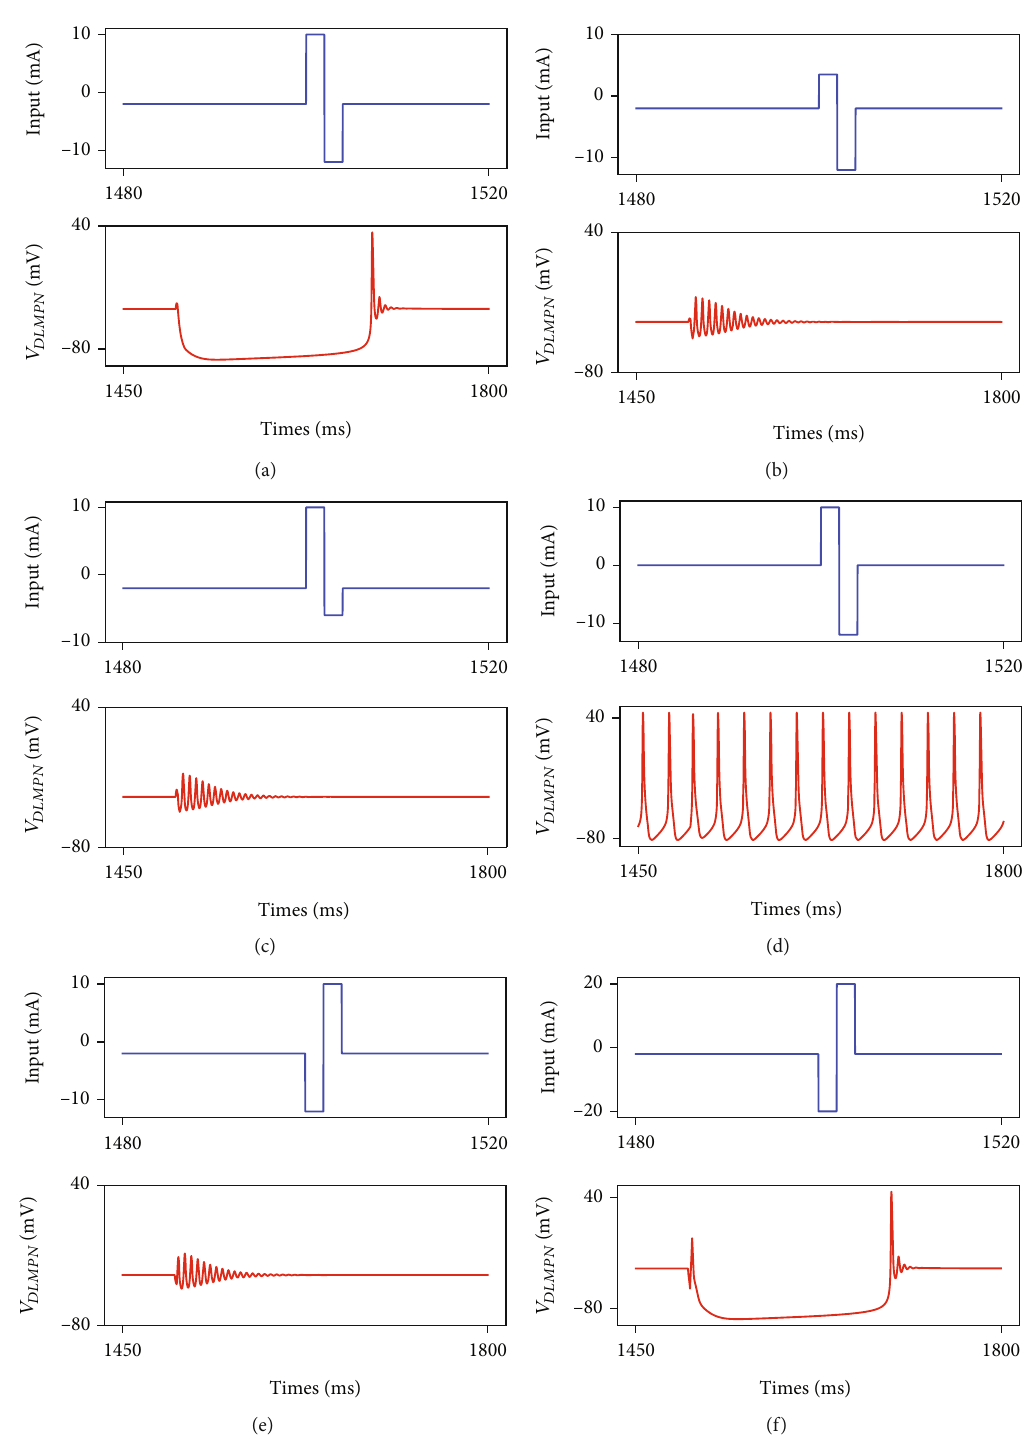
Figure 7: The activities of a single DLM projection neuron under di ff erent currents. (a) I = − 2 mA , I (b) I nor = − 12mA . (e) I I neg represent three types of currents, with I I nor